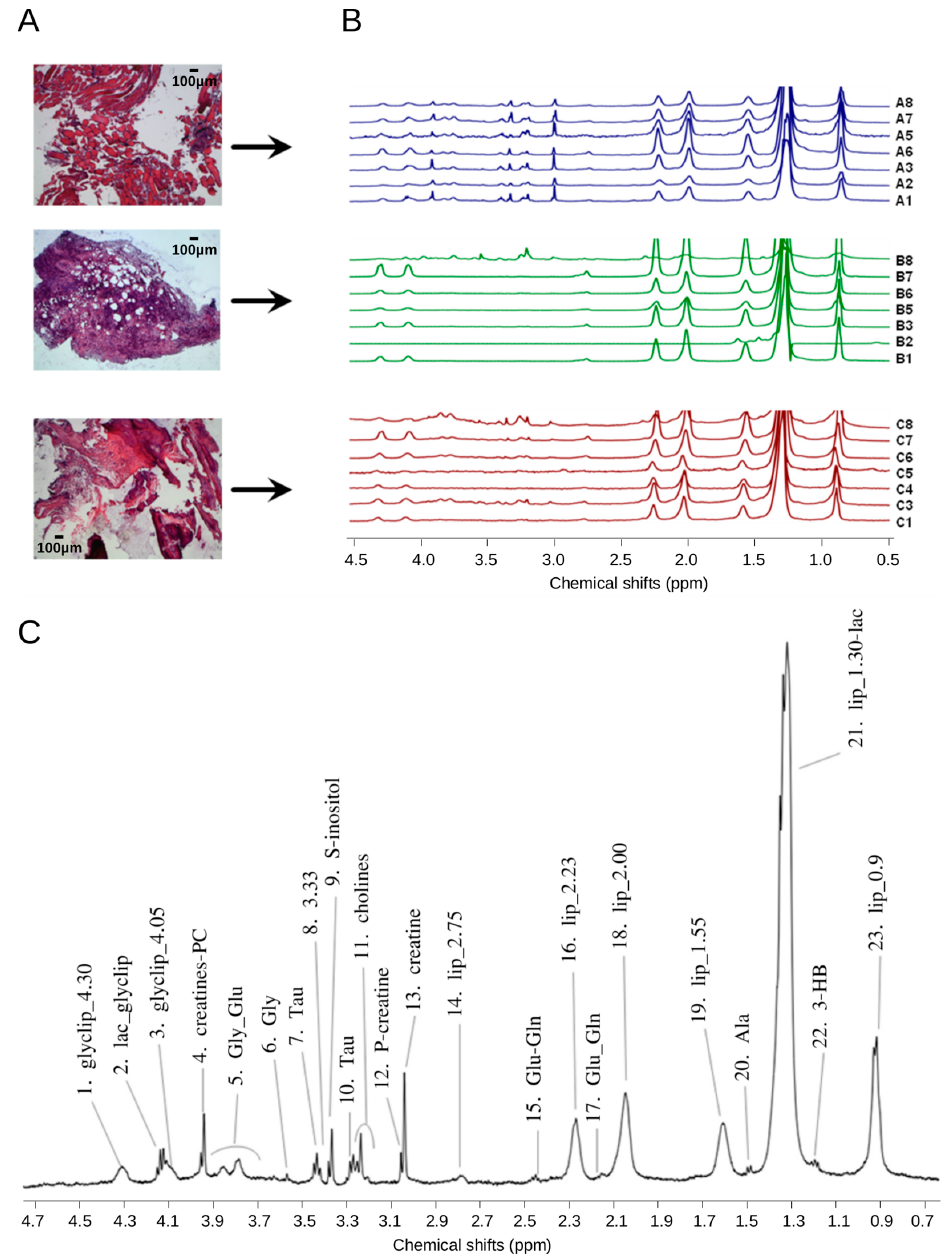
Figure 1. 1 H HR-MAS (high-resolution magic-angle spinning) spectra of multiple biopsy specimens. ( A ) From top to bottom: representative hematoxylin and eosin-stained morphological sections of samples belonging to group A, B, and C, respectively; ( B ) Overlay of the spectra acquired on the different specimens; the labels on the right indicate group and sample ID; ( C ) Representative 1 H 1D-noesygppr HR-MAS nuclear magnetic resonance (NMR) spectrum of group A sample. Assignment was made on the basis of literature references [7,22,24–27]. Peaks were calibrated using DSS (4,4-dimethyl-4-silapentane-1-sulfonic acid) peak at 0 ppm as reference. Numbers identify binning regions as listed in Supplementary Table S1. (1) glycerolipids; (2) lactate, glycerolipids; (3) glycerolipids; (4) creatine and phosphocreatine; (5) glycogen, glucose; (6) glycine; (7) taurine; (8) unknown; (9) scyllo-inositol; (10) taurine; (11) choline, O -phosphocholine, and glycerophosphocholine; (12) phosphocreatine; (13) creatine; (14) triglyceride =CH–CH 2 –CH=; (15) glutamate and glutamine; (16) triglyceride CH 2 –CH 2 CO; (17) glutamate and glutamine; (18) triglyceride CH=CH–CH 2 ; (19) triglyceride CH 2 –CH 2 CO; (20) alanine; (21) triglyceride (CH 2 )n, lactate and threonine; (22) 3-hydroxybutyrate; (23) triglyceride CH 3 –(CH 2